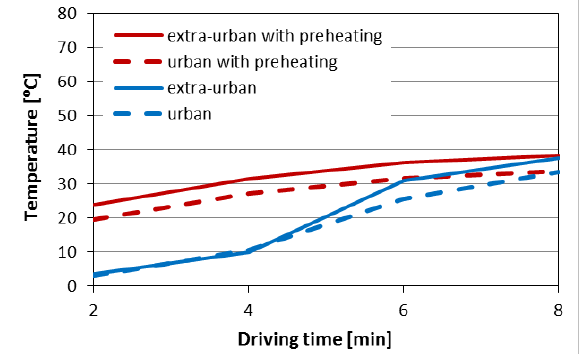
Fig. 9. Temperature increase of the supplied air to the vehicle cabin on the test track “urban” and “extra-urban” as a function of driving time with and without engine